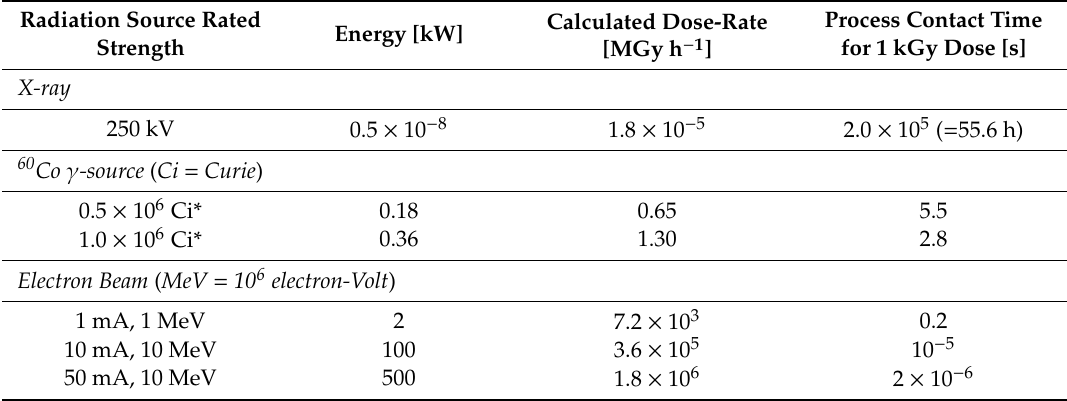
Table 2. Achievable dose-rates and process contact times of di ff erent radiation sources.